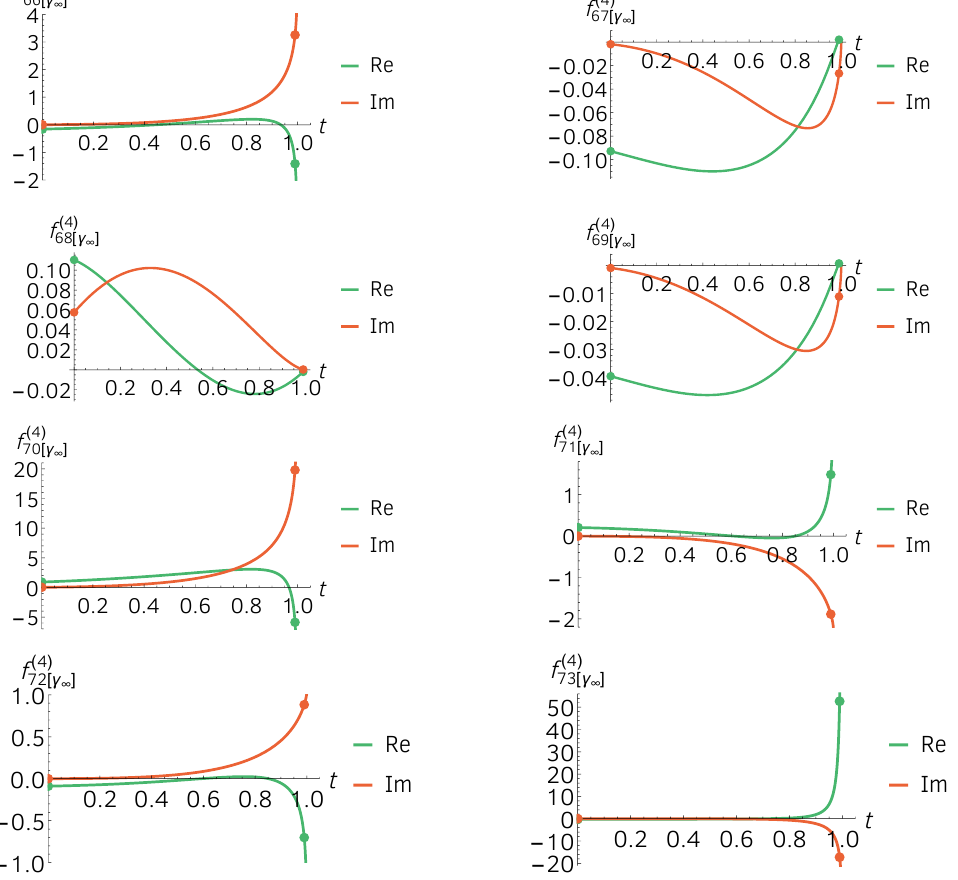
Figure 4 . Plots along the contour (cid:13) 1 , for values of the contour parameter t 2 [0 ; 1]. The solid points represent values computed numerically with the software FIESTA [51].